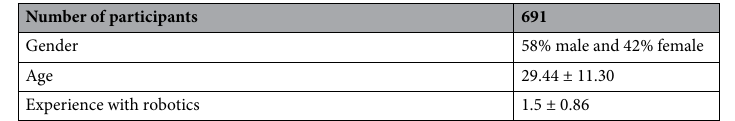
Table 1. Demographic characteristics and experience with robotics on a scale from 1 (minimum experience) to 5 (maximum experience) collected during the first part of the